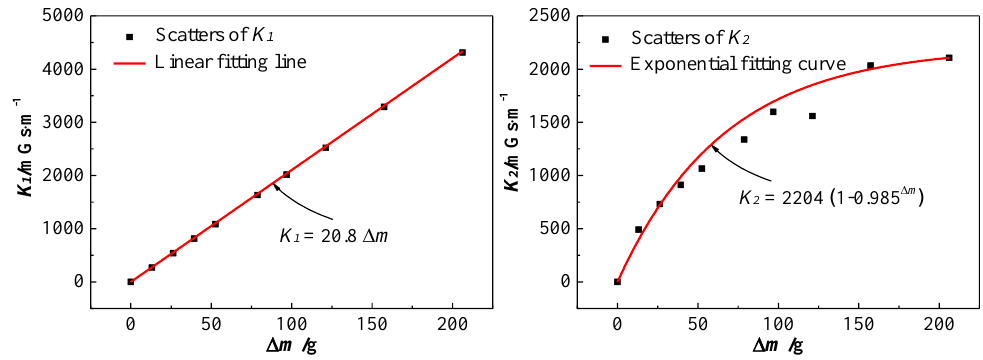
Figure 10. Diagram of relationship between K and Δm .